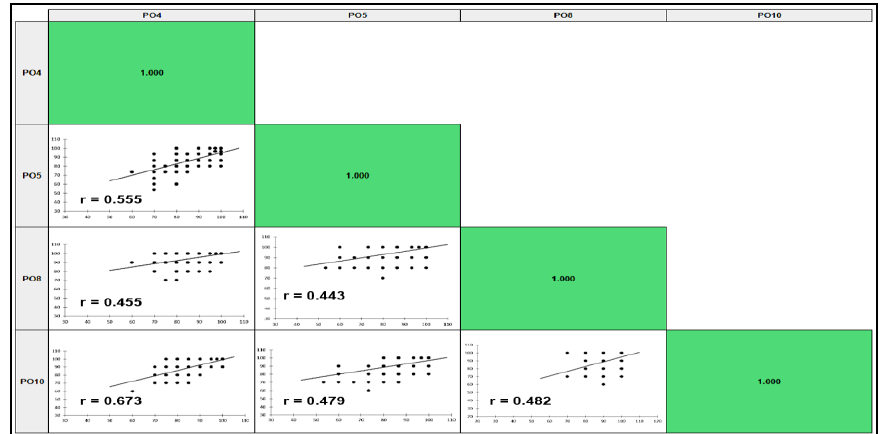
Fig. 4. Correlation matrix between each PO